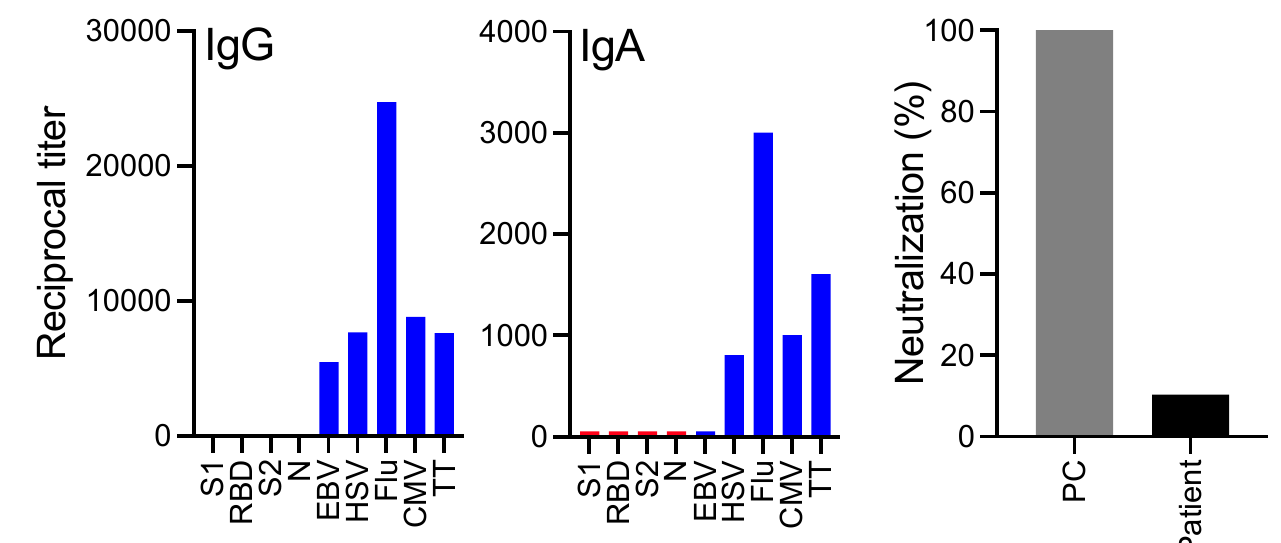
Figure 2. Lack of anti-SARS-CoV antibody responses to vaccination in a patient post kidney transplant. IgG and IgA antibody titers against the SARS-CoV proteins S1, RBD, S2, and N (red bars) and titers against control proteins Flu, EBV, HSV, CMV, and TT (blue bars) were measured by an ELISA. The neutralizing activity of the patient’s serum and a positive control (PC) are shown on the right.